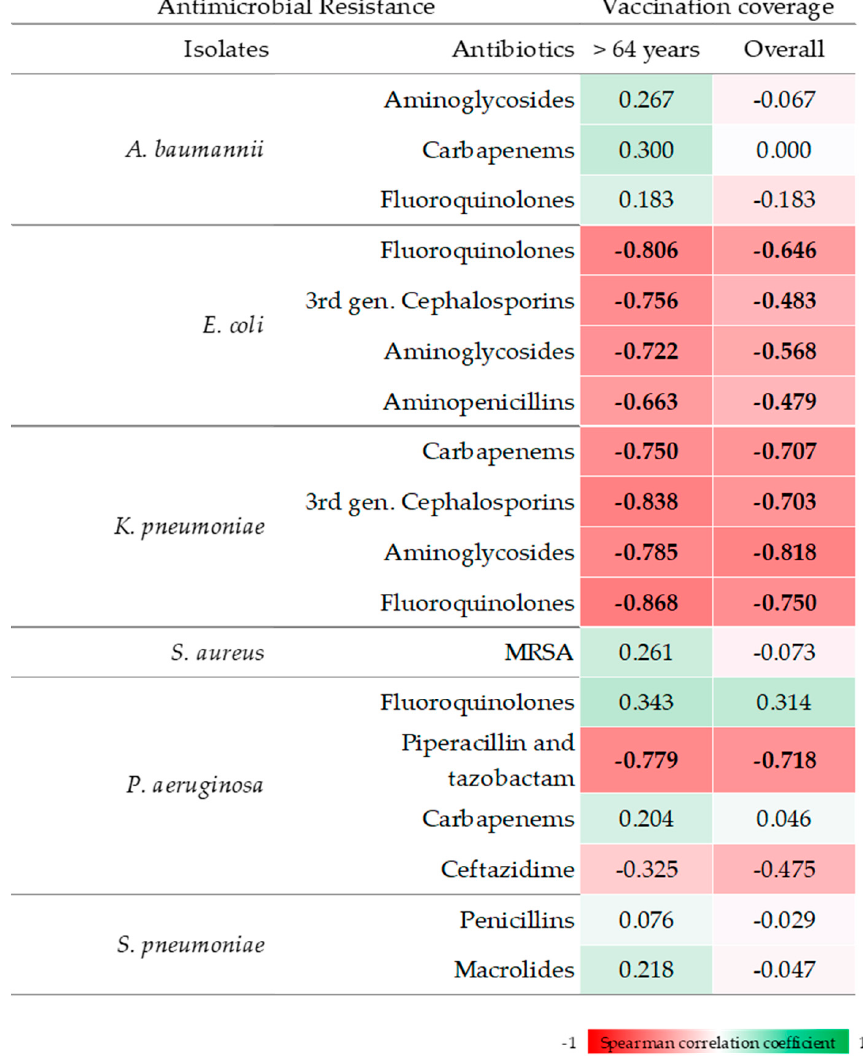
Figure 2. Spearman’s Correlations between influenza vaccination coverage and antimicrobial resistance. Correlations coefficients with p < 0.05 are indicated in bold font.